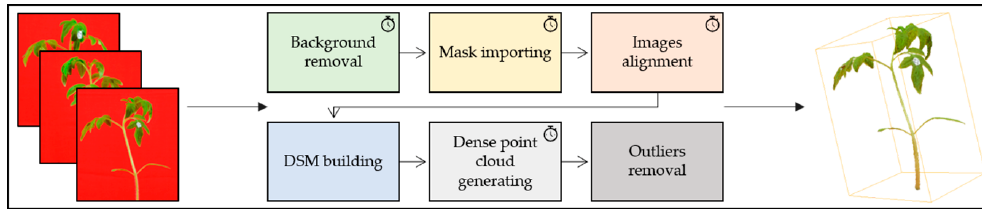
Figure 3. Workflow of image processing with specific timed steps.